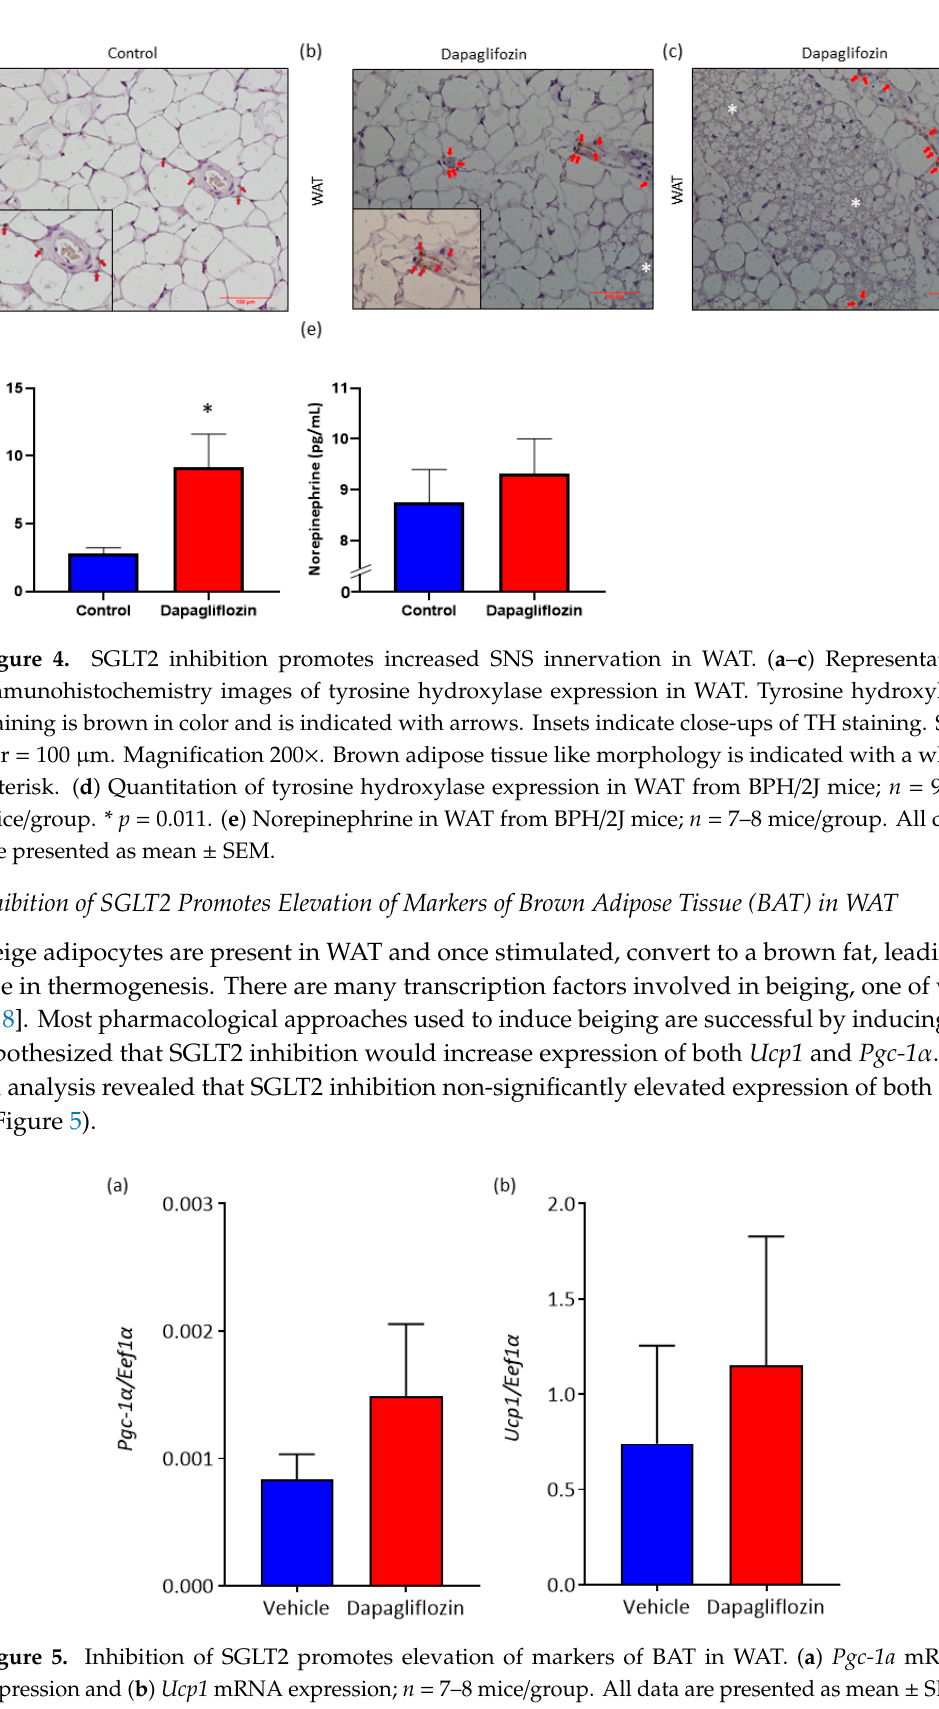
Figure 5. Inhibition of SGLT2 promotes elevation of markers of BAT in WAT. ( a ) Pgc-1a mRNA expression and ( b ) Ucp1 mRNA expression; n = 7–8 mice/group. All data are presented as mean ± SEM.